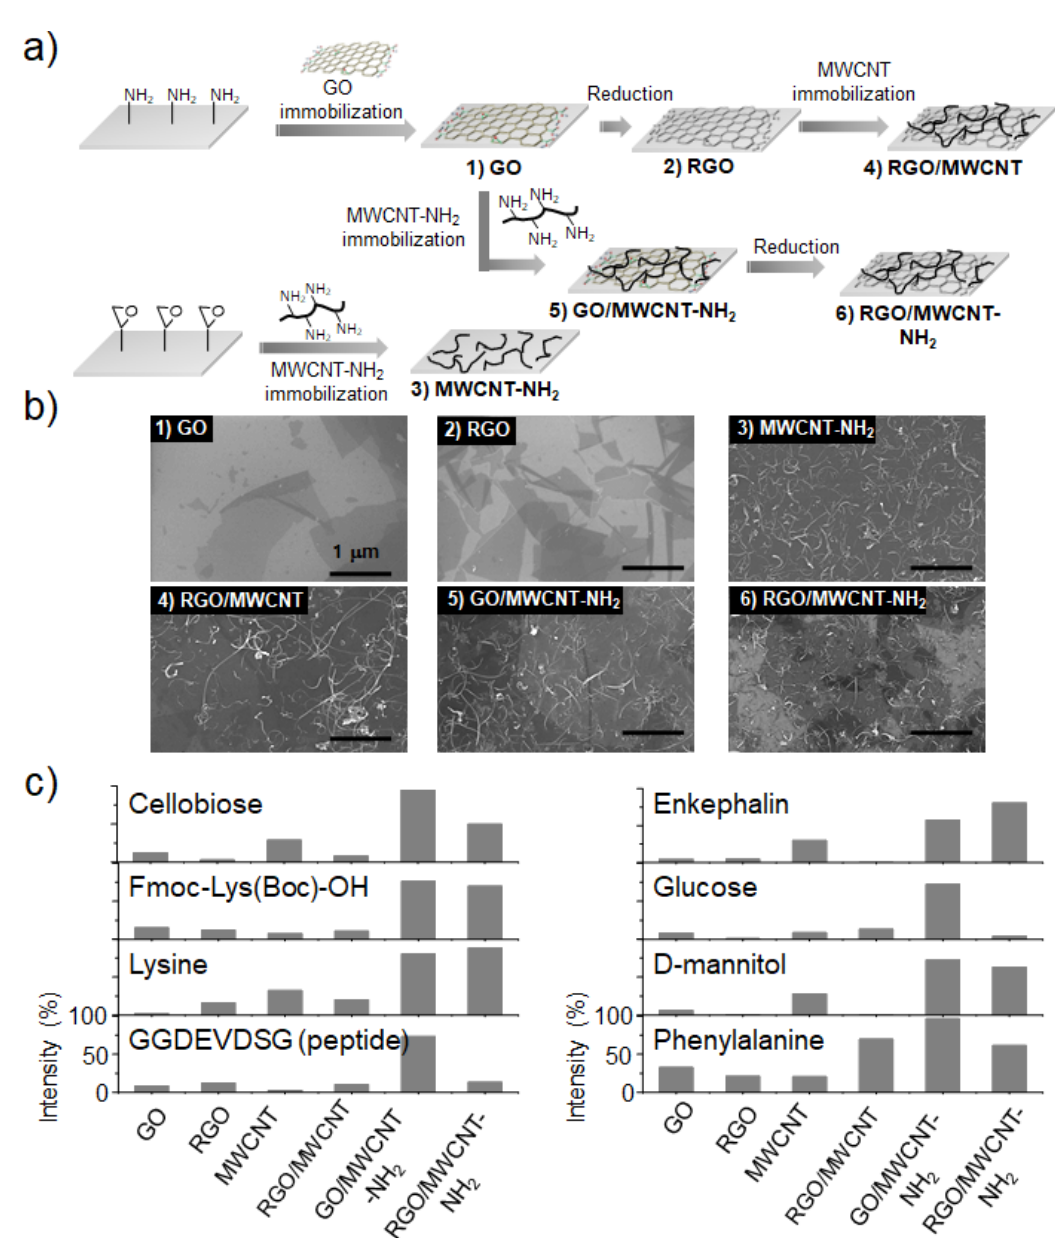
Figure 4. ( a ) Fabrication processes and ( b ) scanning electron microscopy (SEM) images of GO, RGO, MWCNT-NH 2 , RGO/MWCNT, GO/MWCNT-NH 2 and RGO/MWCNT-NH 2 nanohybrid films. ( c ) The relative mass signal intensities of various small molecules such as cellobiose, Leu-enkephalin, Fmoc-Lys(Boc)-OH, phenylalanine, glucose, lysine, D-mannitol and GGDEVDSG peptide. Adapted with permission from ref. [71]. Copyright 2011 American Chemical Society.